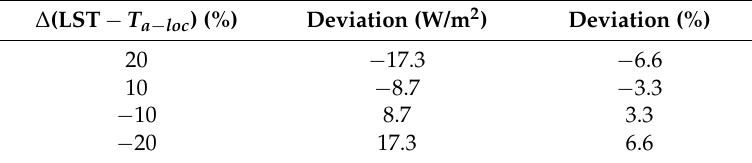
Table 8. Deviations in ET after perturbing LST ´ T a – loc